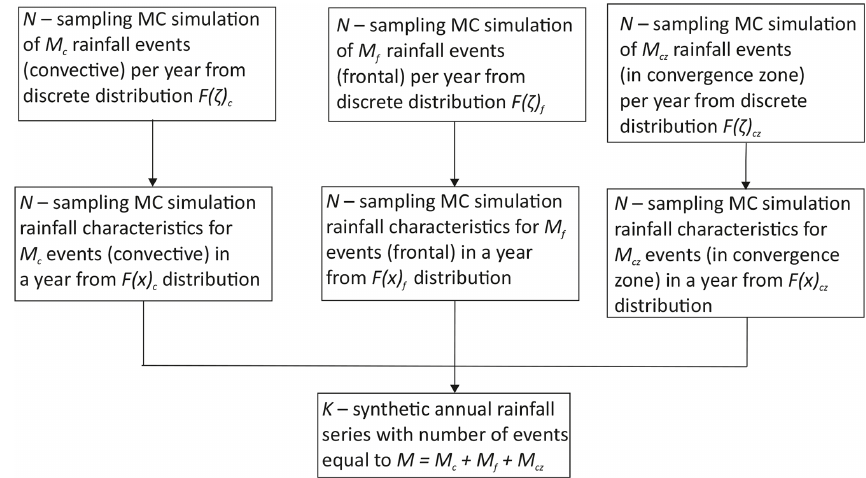
Figure 4. Algorithm of the simulation of annual rainfall series, taking into account the generation of rainfall. N – number of modeled samples for M rainfall events ( N = 500); K – number of samples of rainfall characteristics modeled with the IC + LH method ( K = 1000); explanations of the other symbols are in the Appendix.